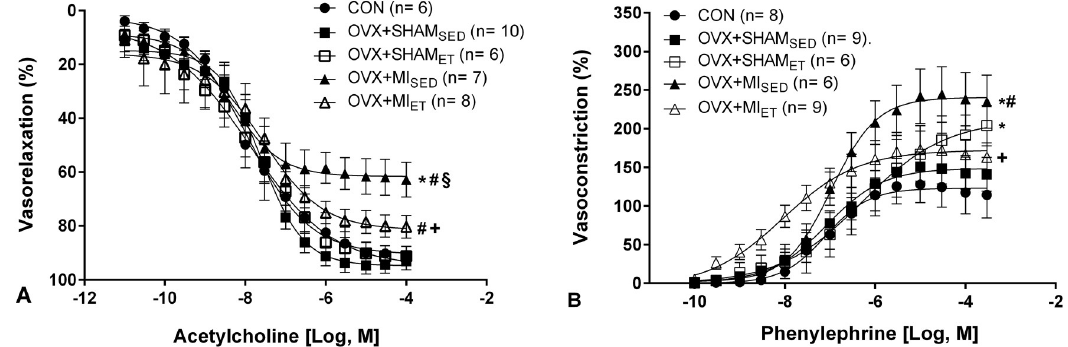
Fig 2. Concentration-response curves to acetylcholine (A) and phenylephrine (B) in isolated aortic rings of Wistar rats. Data are expressed as mean ± standard error of the mean (SEM). Two-way ANOVA followed by the Fisher post-hoc test for multiple comparisons. � p < 0.05 vs control; # p < 0.05 vs OVX+SHAM SED ;. § p < 0.05 vs OVX+SHAM ET ; + p < 0.05 vs OVX+MI SED